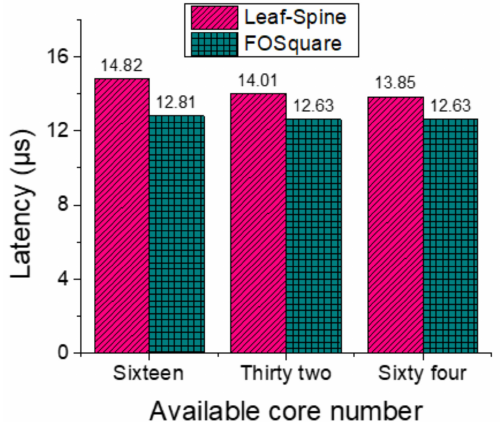
Figure 7. MG application Latency.